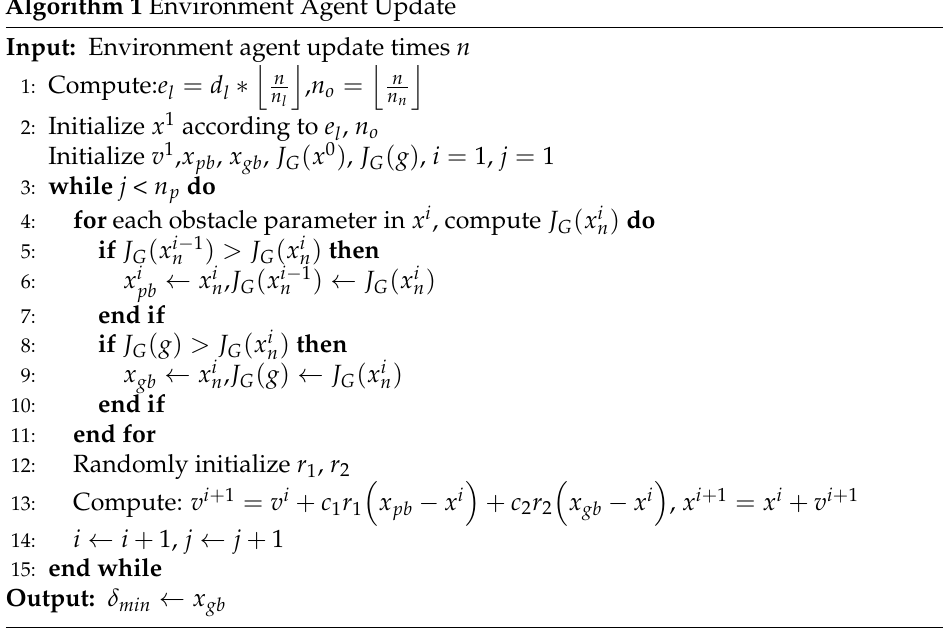
Algorithm 1 Environment Agent